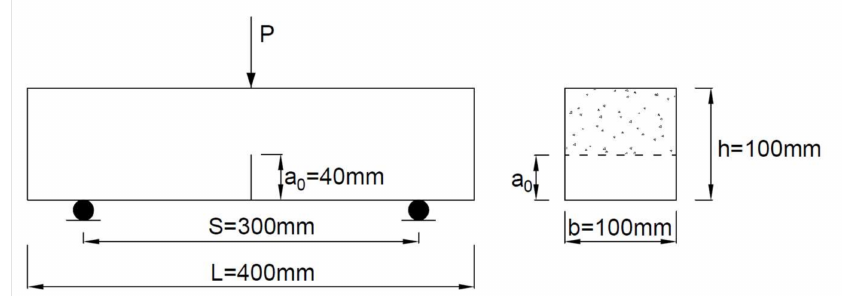
Figure 3. Schematic diagram of specimen for fracture testing.